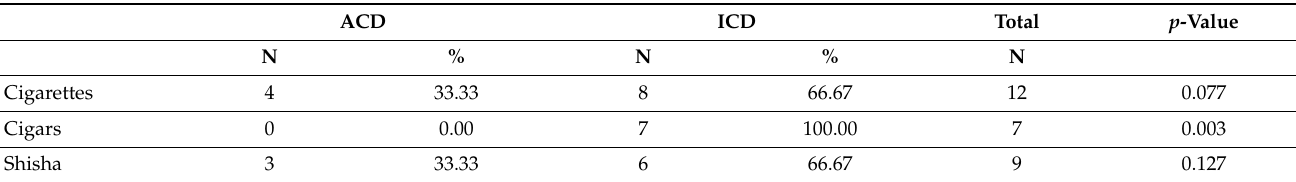
Table 4. Relation of tobacco smoking type with ICD and